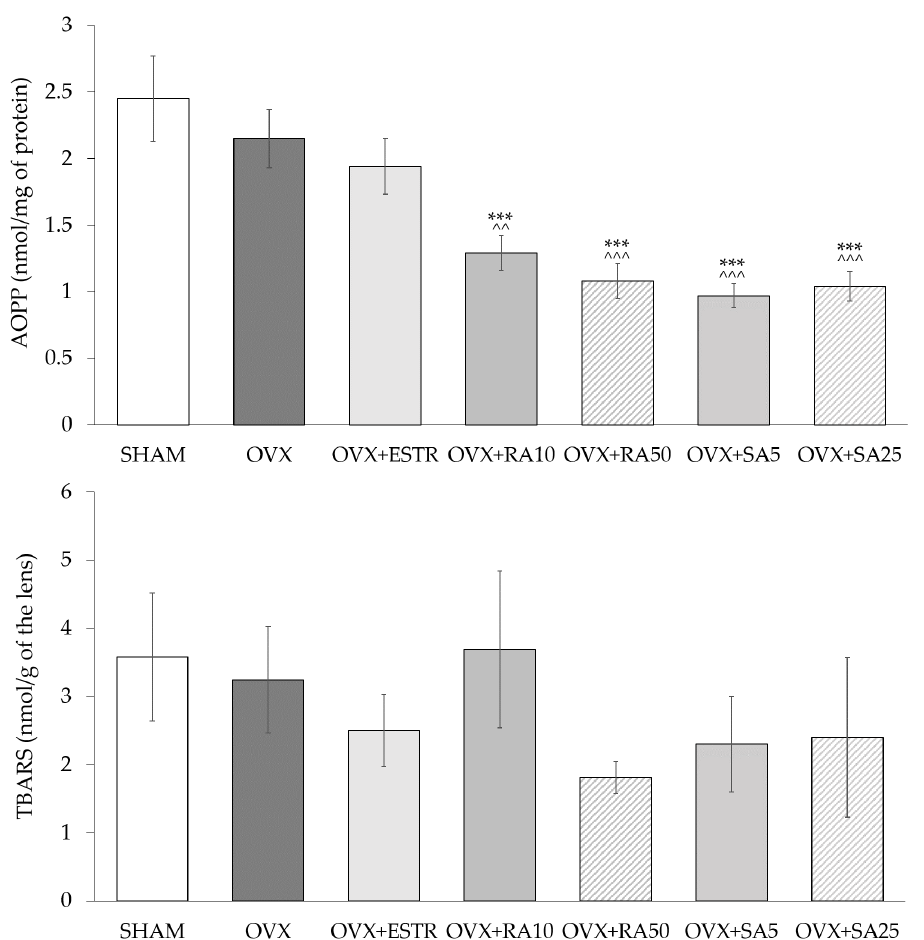
Figure 1. Effect of rosmarinic acid and sinapic acid on the AOPP and TBARS content in the lenses of ovariectomized rats. Rosmarinic acid at doses of 10 mg/kg (OVX + RA10) and 50 mg/kg (OVX + RA50), sinapic acid at doses of 5 mg/kg (OVX + SA5) and 25 mg/kg (OVX + SA25) or estradiol at a